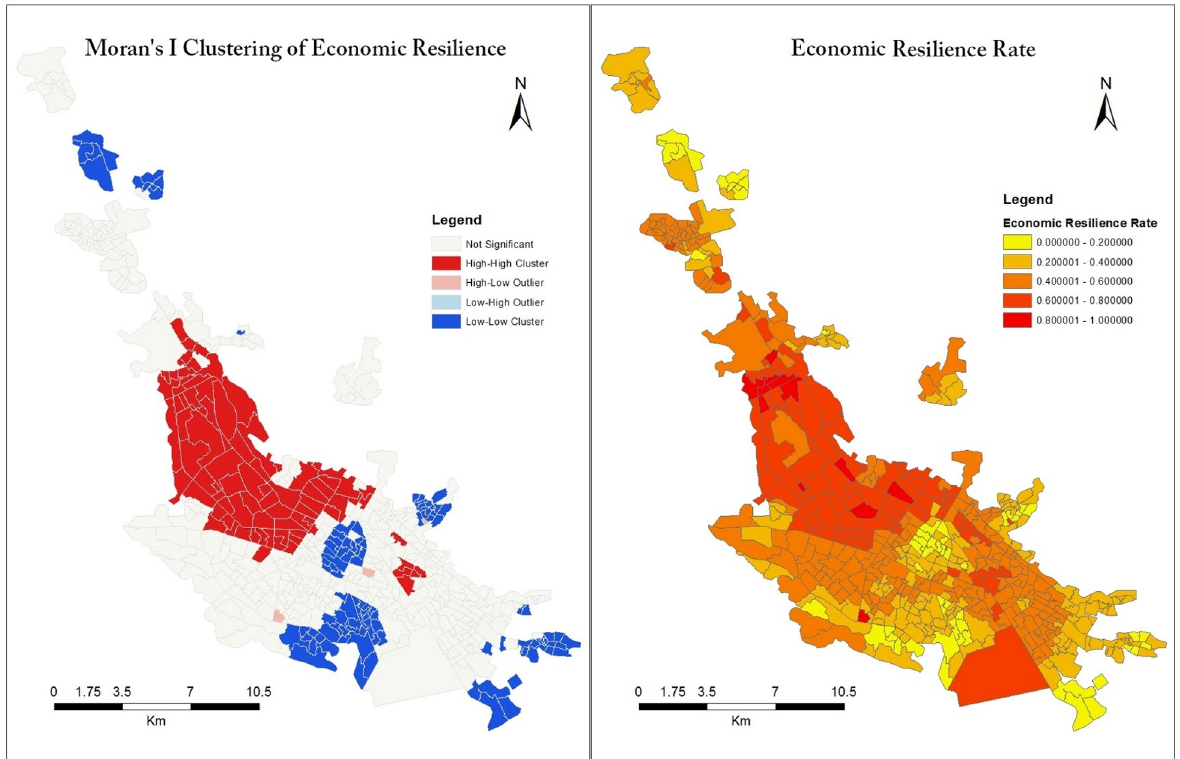
Figure 5 Economic urban resilience value distribution in the case of Shiraz. Figure 5. Economic urban resilience value distribution in the case of